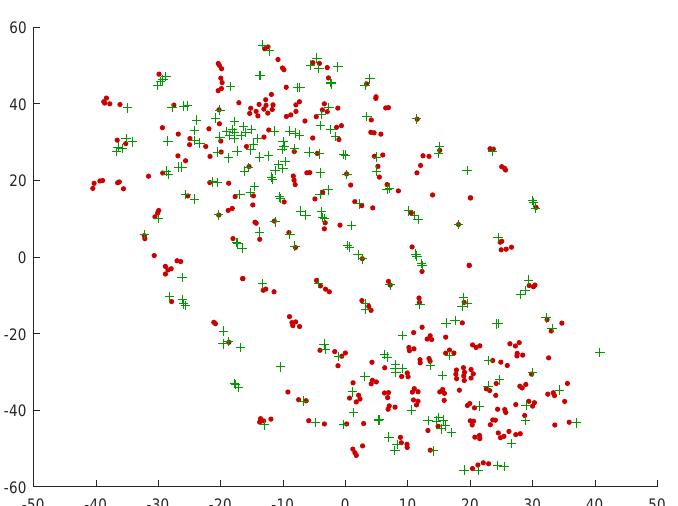
Figure 4. Positive (green plus markers) and negative (red dots) arousal samples in the MAHNOB database, on the representation space produced by t-SNE.